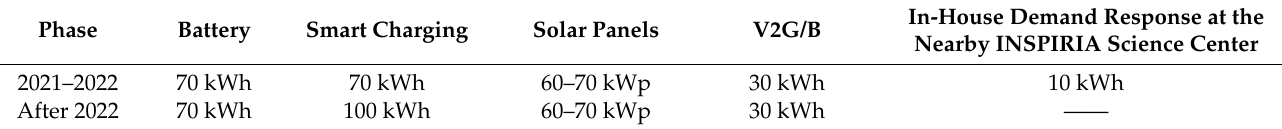
Table 3. Possible utilization of local flexibility resources at the INSPIRIA charging station and their timeline.